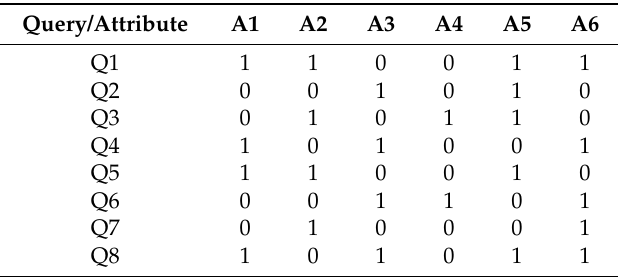
Table 4. Attribute incidence matrix (AIM).